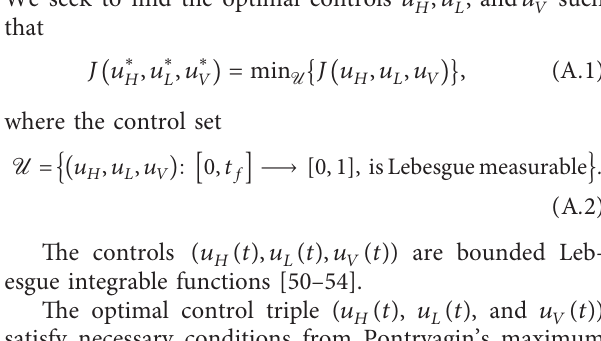
Figure 19: Simulations of the malaria-resistant model (21) as a function of time plotting the average control levels for controls u u H in West, Central, East, Central, and South